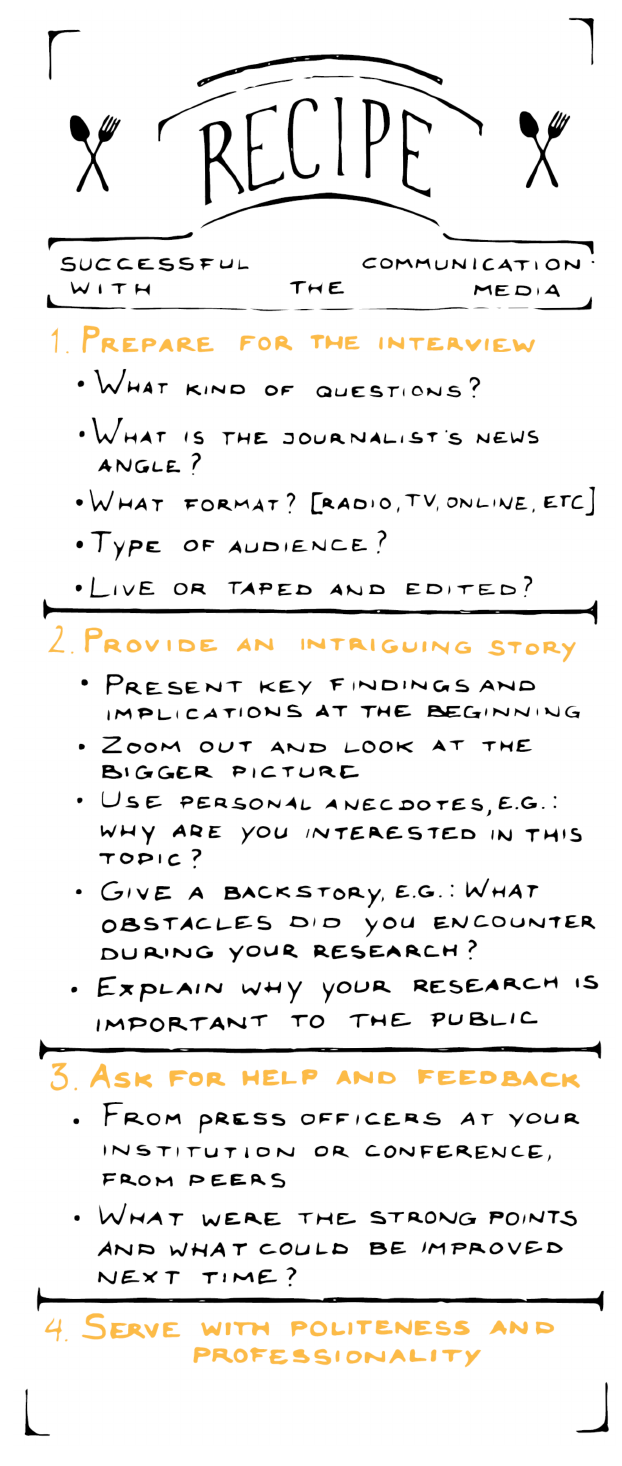
Figure 3. Our suggestions for successful communication between science and the media (figure by Cher van den